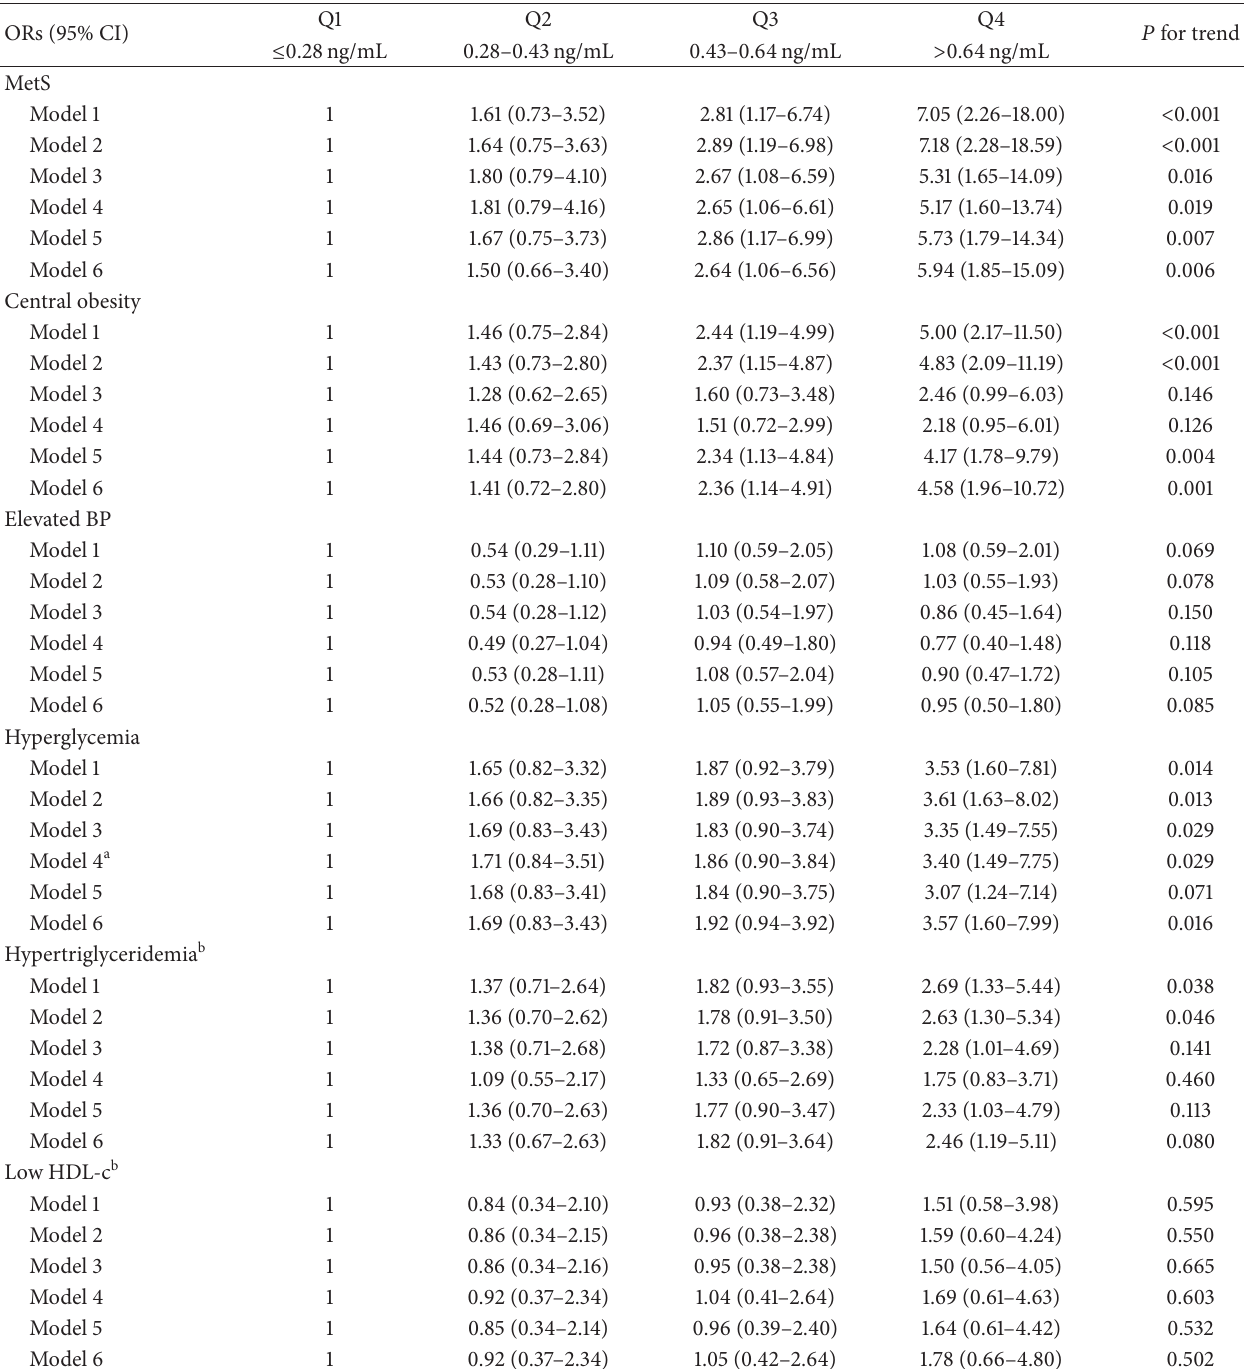
Table 5: Multiple logistic regression analysis of baseline fractalkine quartiles in the prediction of MetS and its components at year 2: ORs ( 𝑛 = 390